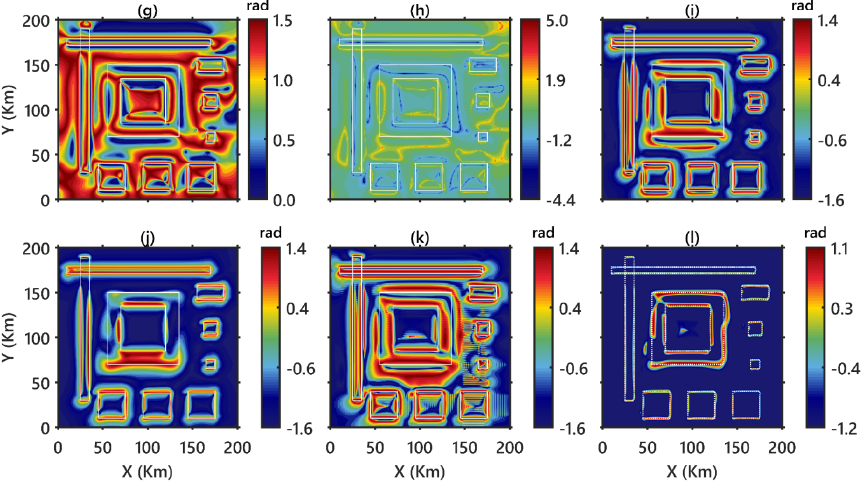
Figure 6. The third case. ( a ) The magnetic anomaly; ( b ) HG; ( c ) AS; ( d ) TA; ( e ) TM; ( f ) HGTA; ( g ) TDX; ( h ) HTA; ( i ) TAHG; ( j ) TAAS; ( k ) TBHG; and ( l ) ETG. The white lines show the true edge of the prisms.